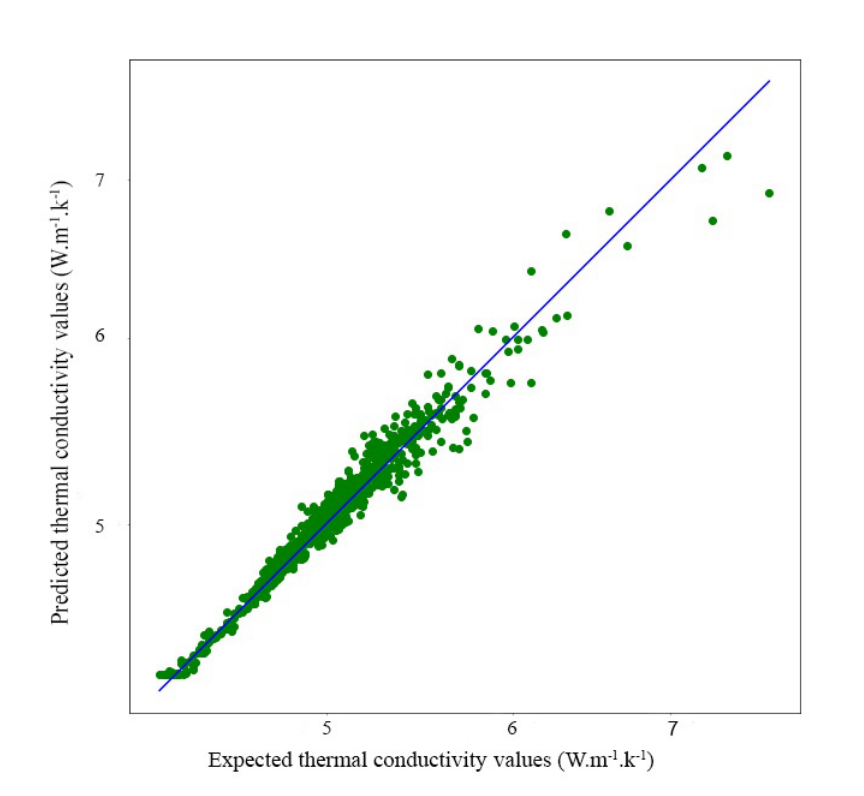
Figure 13. Convolutional predictions for the thermal